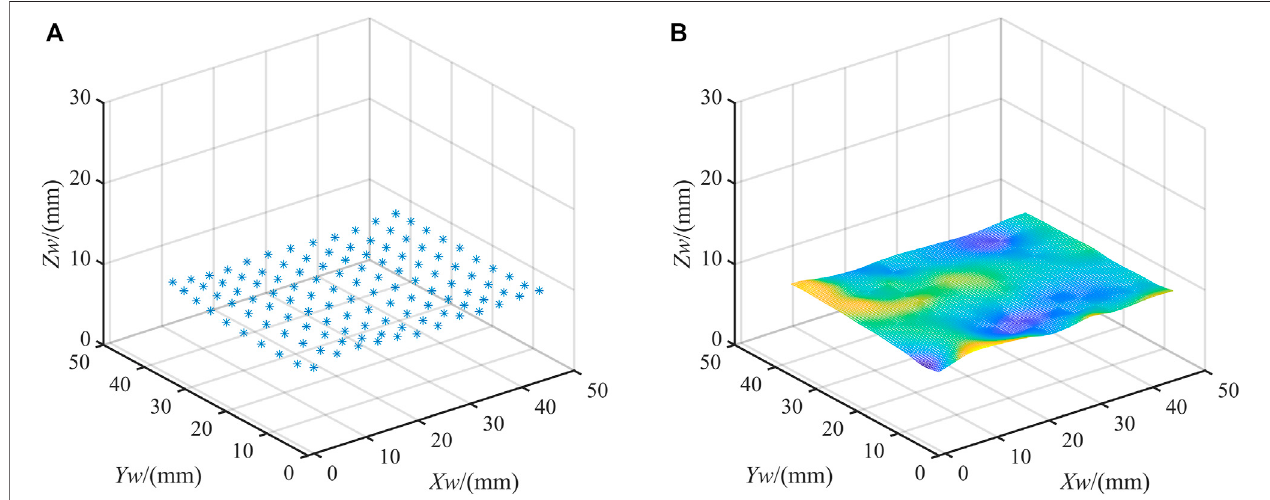
FIGURE 6 | Results. (A) Prediction results of sample points; (B) The plane fi tting results.